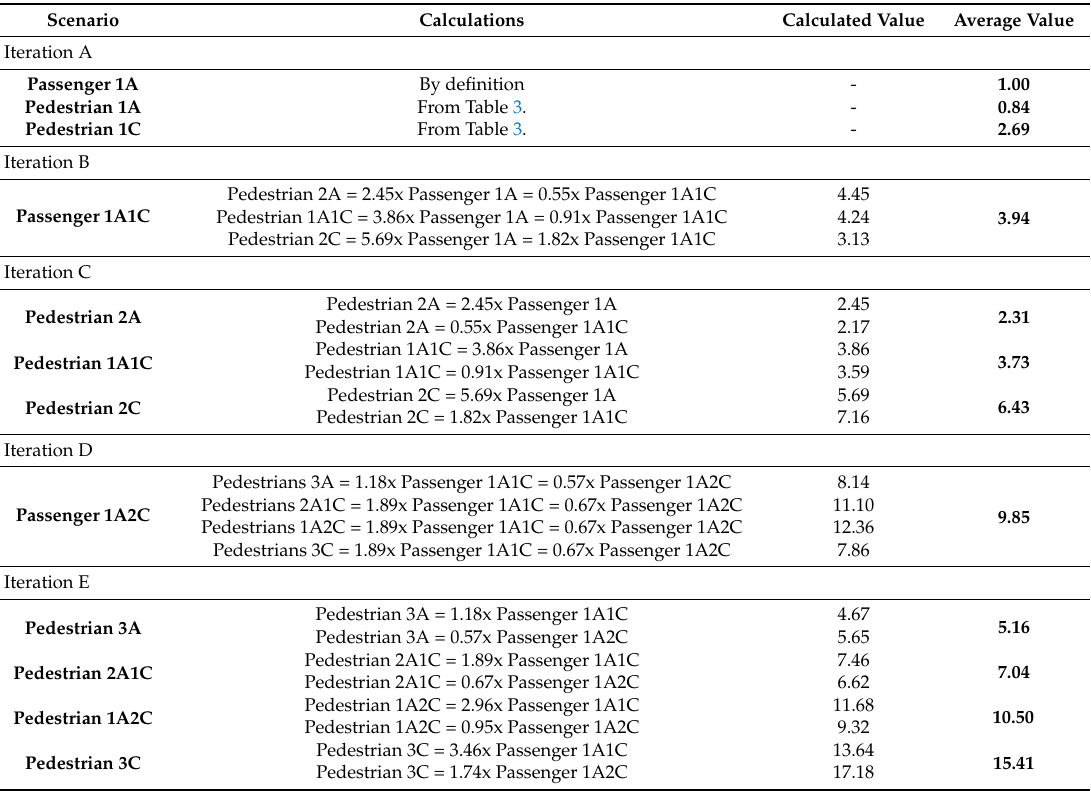
Table 4. Absolute value by scenario (expressed in adult driver lives equivalents).